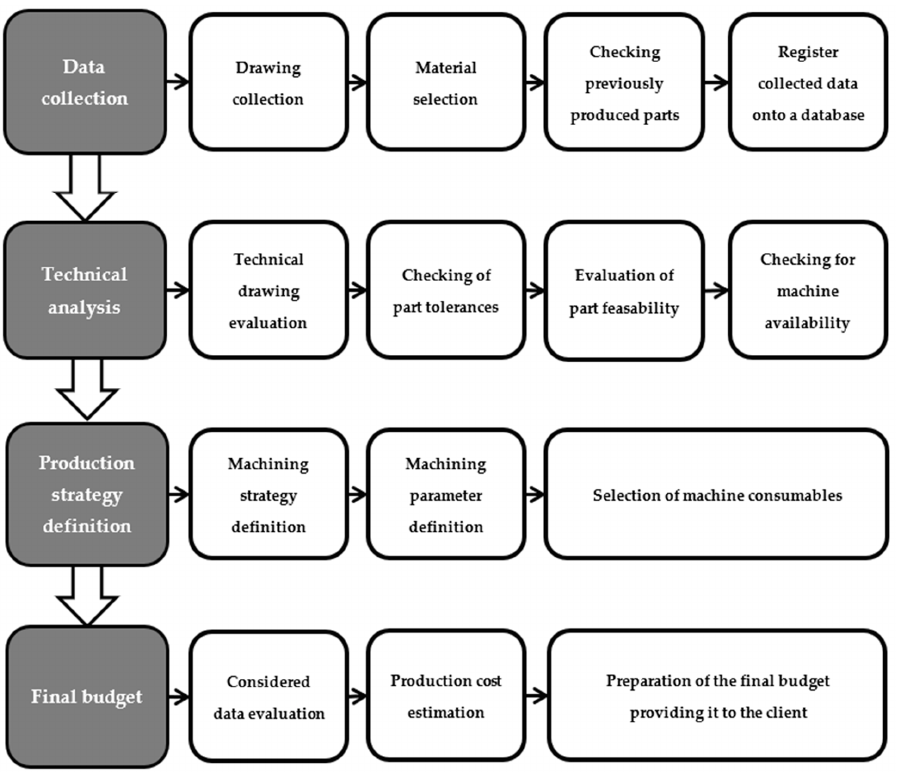
Figure 1. Schematic representation of the conventional budgeting process.